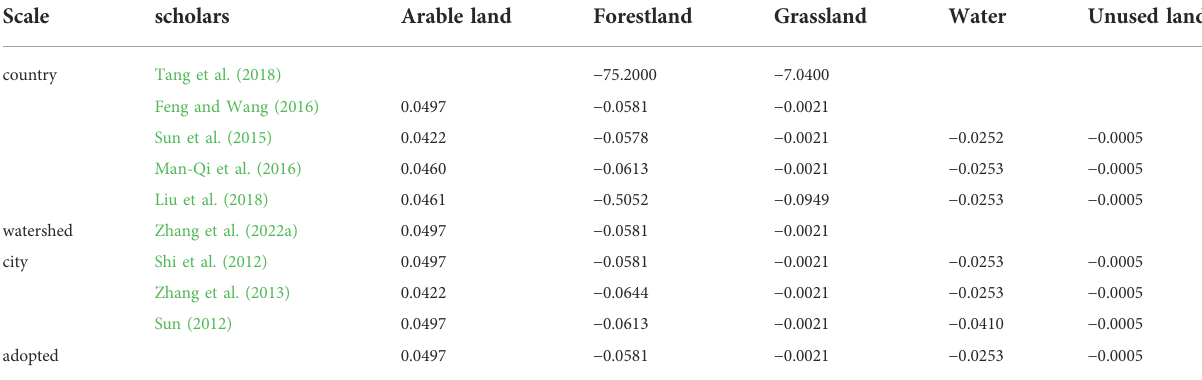
TABLE 1 Carbon emissions and sequestration coef fi cients of different site types.